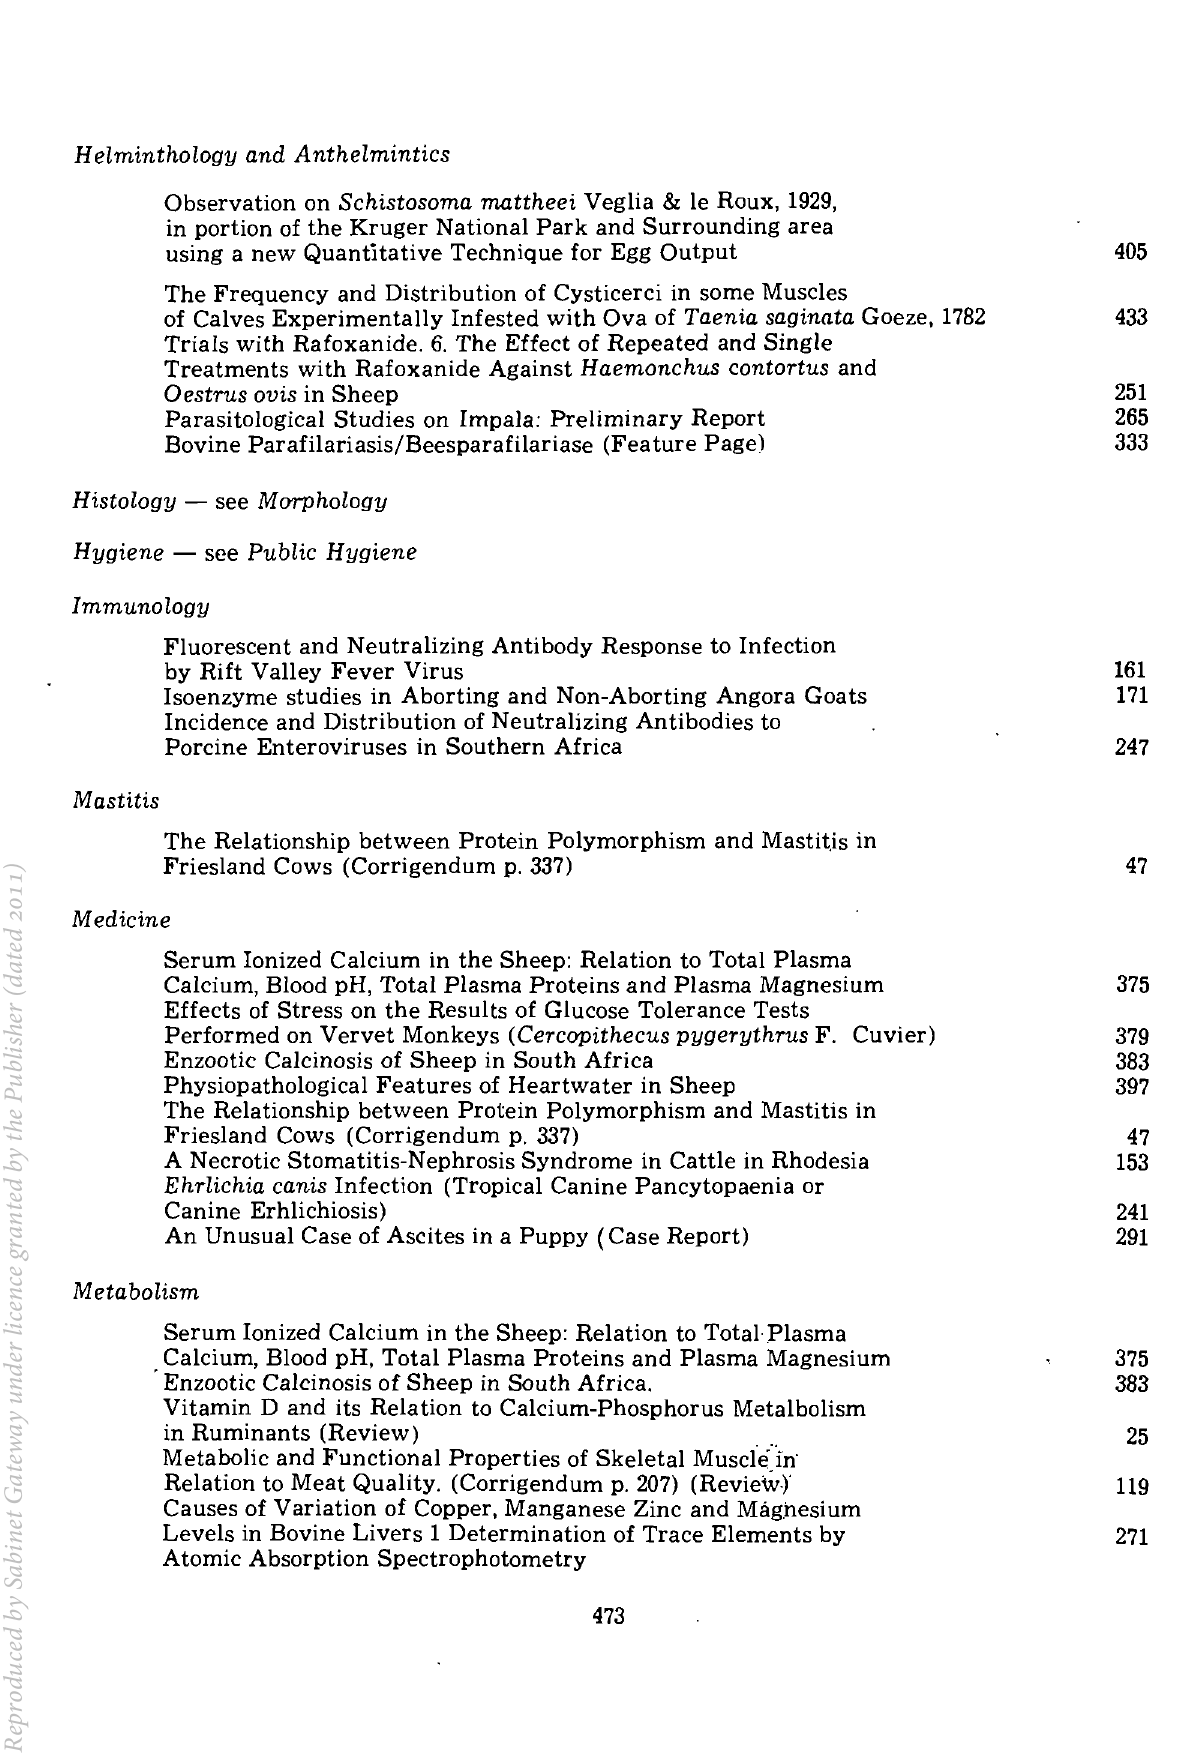
Serum Ionized Calcium in the Sheep: Relation to Totall'lasma Calcium, Blood pH, Total Plasma Proteins and Plasma Magnesium . Enzootic Calcinosis of Sheep in South Africa. Vitamin D and its Relation to Calcium-Phosphorus Metalbolism in Ruminants (Review) Relation to Meat Quality. (Corrigendum p. 207)